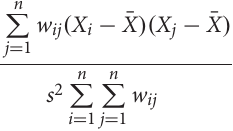
upper- (H-L, the lower-right quadrant), and low-low (L-L, the lower-left quadrant) spatial correlation. Figure 9 visualizes the local spatial correlation. (1) H-H quadrant: A province in the H-H quadrant means it enjoys higher resilience of sports development, so do its surroundings and neighboring provinces, showing a small spatial difference. Jiangsu, Zhejiang, Shandong, Jiangxi, and Henan provinces, as well as Beijing Municipality, belonged to the H-H quadrant in 2013, among which Jiangsu, Zhejiang, Shandong, and Henan provinces have